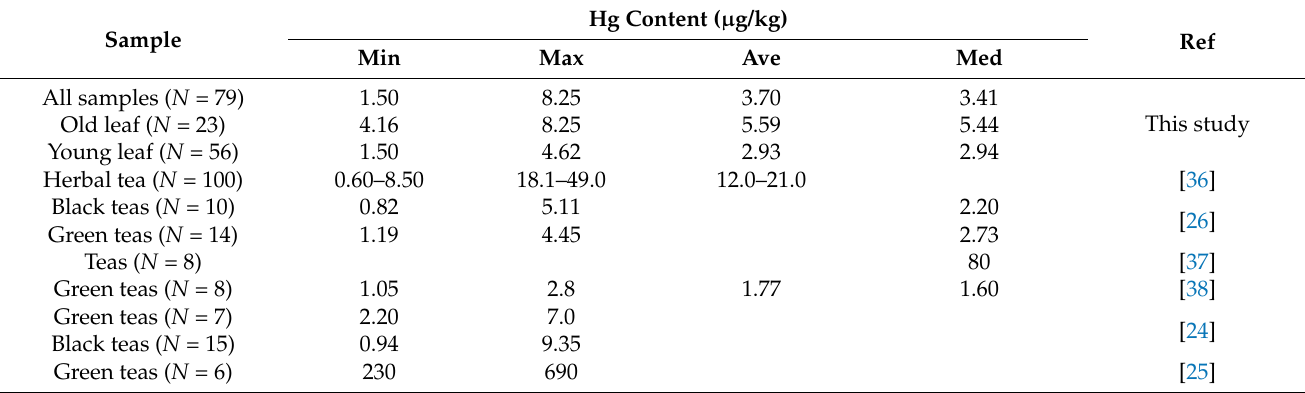
Table 4. Comparison of Hg content in tea leaves.